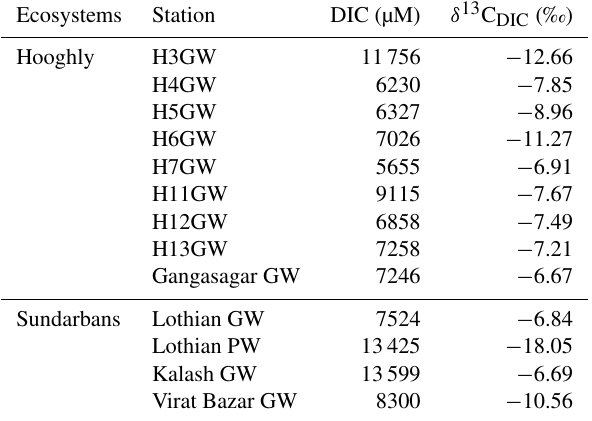
Table 4. The DIC concentrations and δ 13 C DIC of groundwater (GW) and porewater (PW) samples collected around the Hooghly– Sundarbans